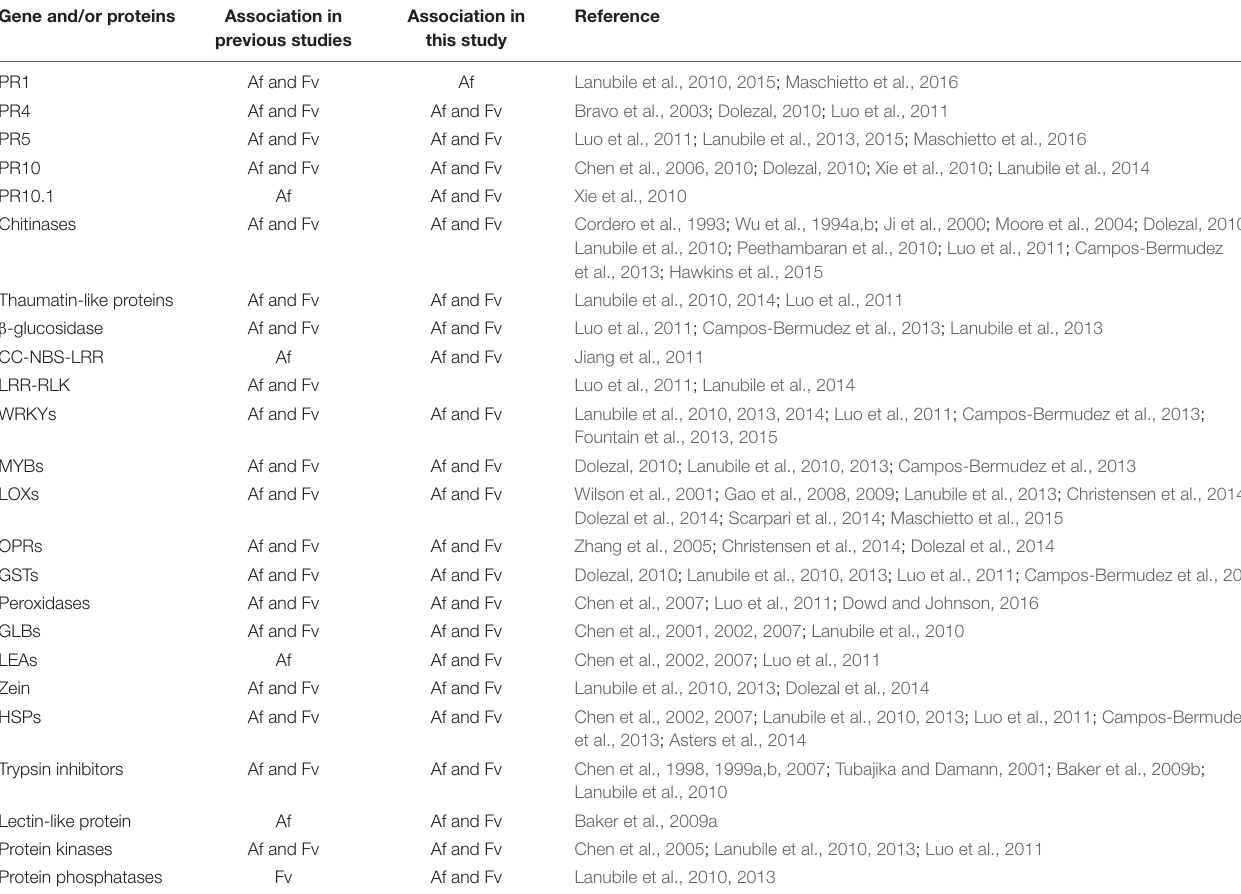
TABLE 1 | Comparison of maize genes and/or proteins that have been observed in this study and in previous studies. Gene and/or